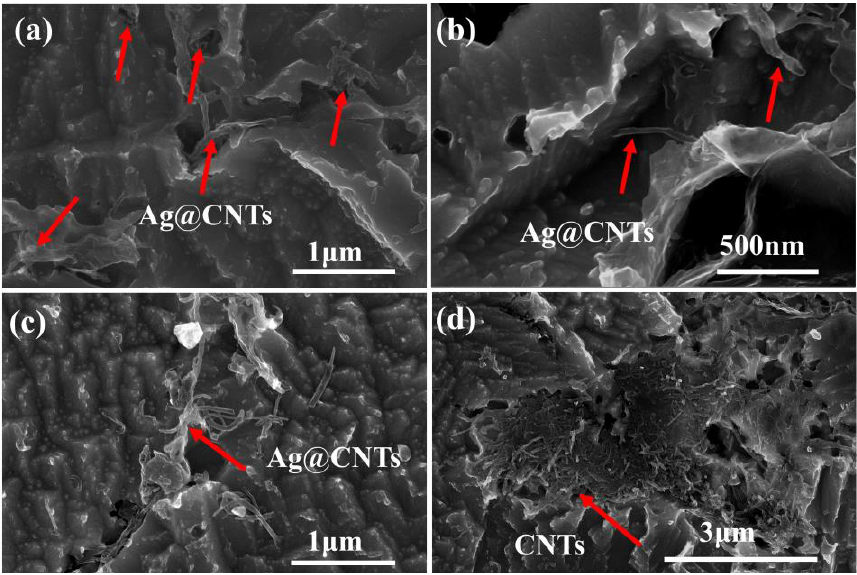
Figure 7. Morphology of the composites after etching: ( a , b ) 0.9 vol.% Ag-CNTs/Cu; ( c ) 1.3 vol.% Ag-CNTs/Cu; ( d ) CNTs/Cu.